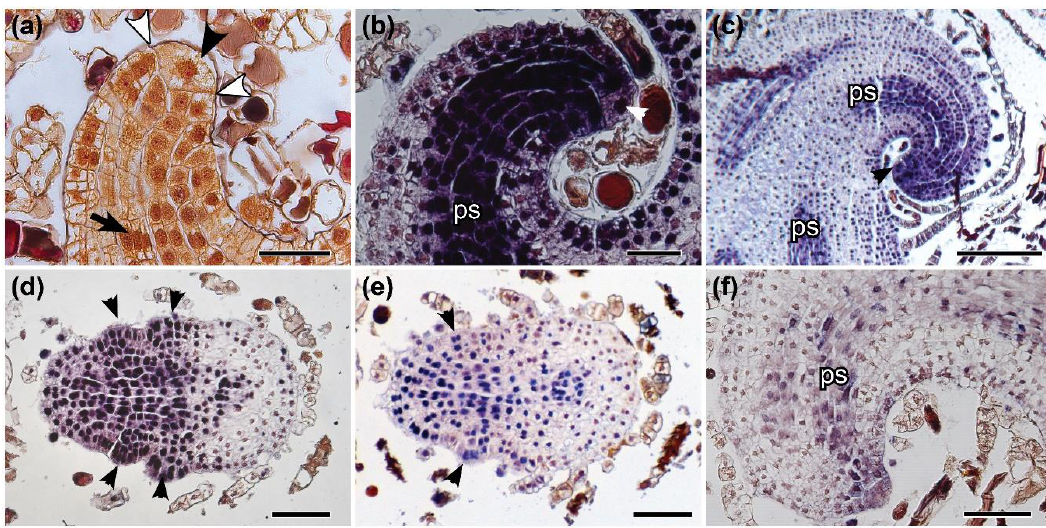
Figure 3. Investigations of leaf development in terrestrial (Tf) and climbing (Cf) forms in Mickelia scandens by anatomical and expression analyses. Longitudinal sagittal sections in ( a – c , f ); paradermal sections in ( d , e ). ( a ) Anatomical section of leaf apex bearing apical cell with a distal lenticular face (black arrowhead) and two dividing proximal cutting faces (their limits pointed out by white arrowheads). Inner derivative cells form the procambium (arrow). In situ hybridization ( b – f ). ( b ) MsC1KNOX1 (Tf) and ( c ) MsC1KNOX2 (Cf) are expressed in the leaf apical cell (arrowhead), derivatives cells, and in procambial strands (ps). ( d ) MsC1KNOX1 (Tf) and ( e ) MsC1KNOX2 (Tf) are expressed in young pinnae primordia (arrowheads). ( f ) MsH4 expression indicates cell division in multiple cells in the apical region and procambial strands (ps). Tf. Bars: ( a , b ) 50, (c) 200, ( d – f ) 100 µm. Pinnae primordia emerge laterally on the developing leaf (Figure 4a). The pinna primordium